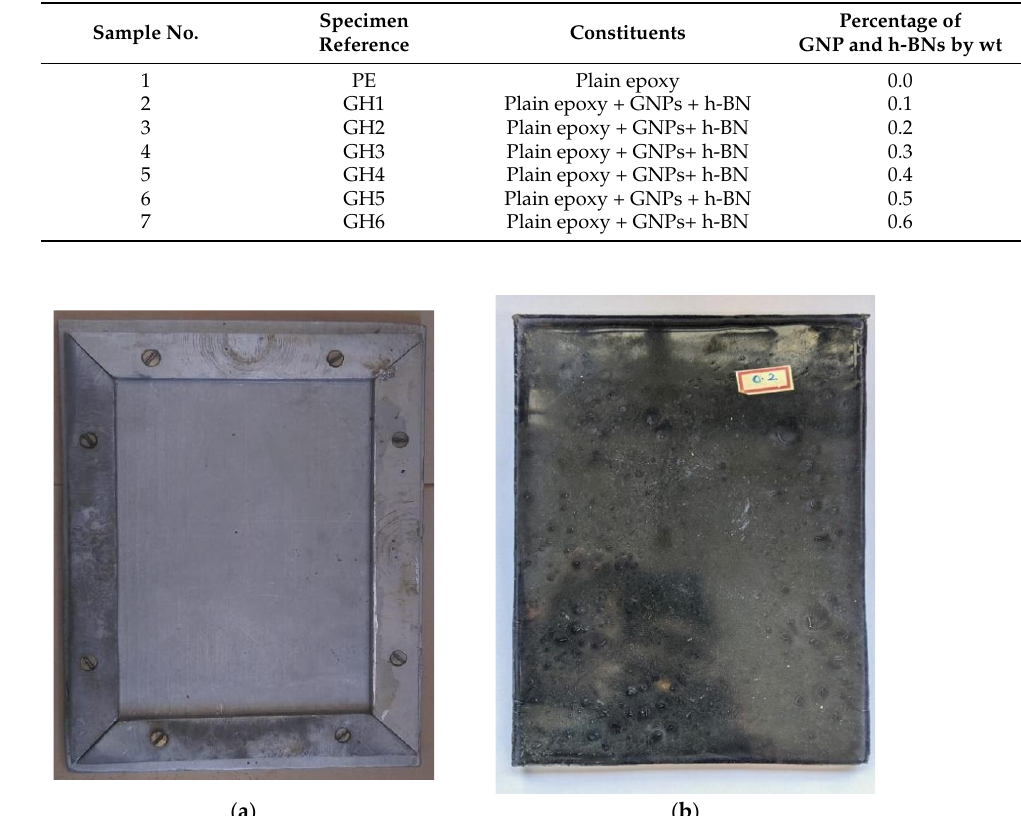
Figure 1. ( a ) Aluminium mould of 230 mm × 164 mm × 6 mm size, ( b ) Epoxy composite plate (0.2 wt % GNP and h-BN).